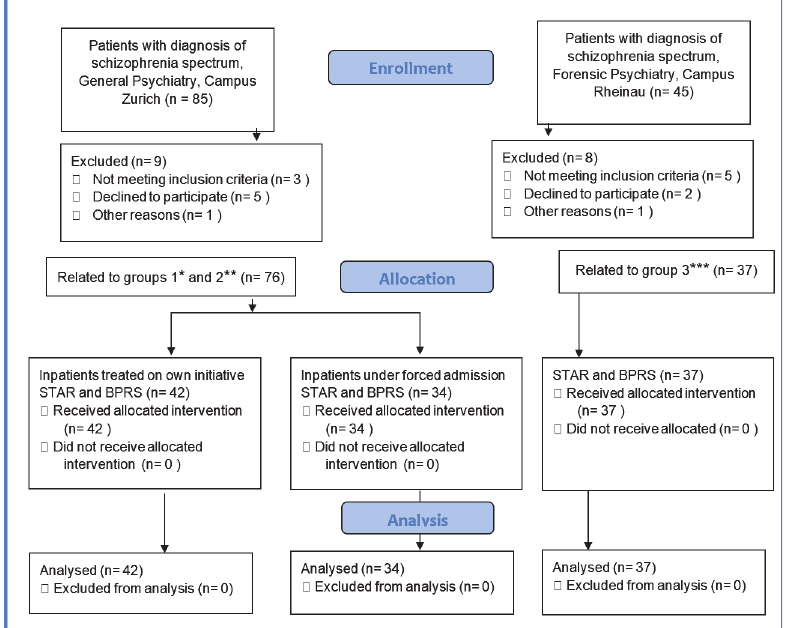
Fig 1. Recruitment. A depiction of the process of enrolment, allocation, and analysis of patients in the three groups: self-referred inpatients, inpatients under involuntary admission, and forensic inpatients.